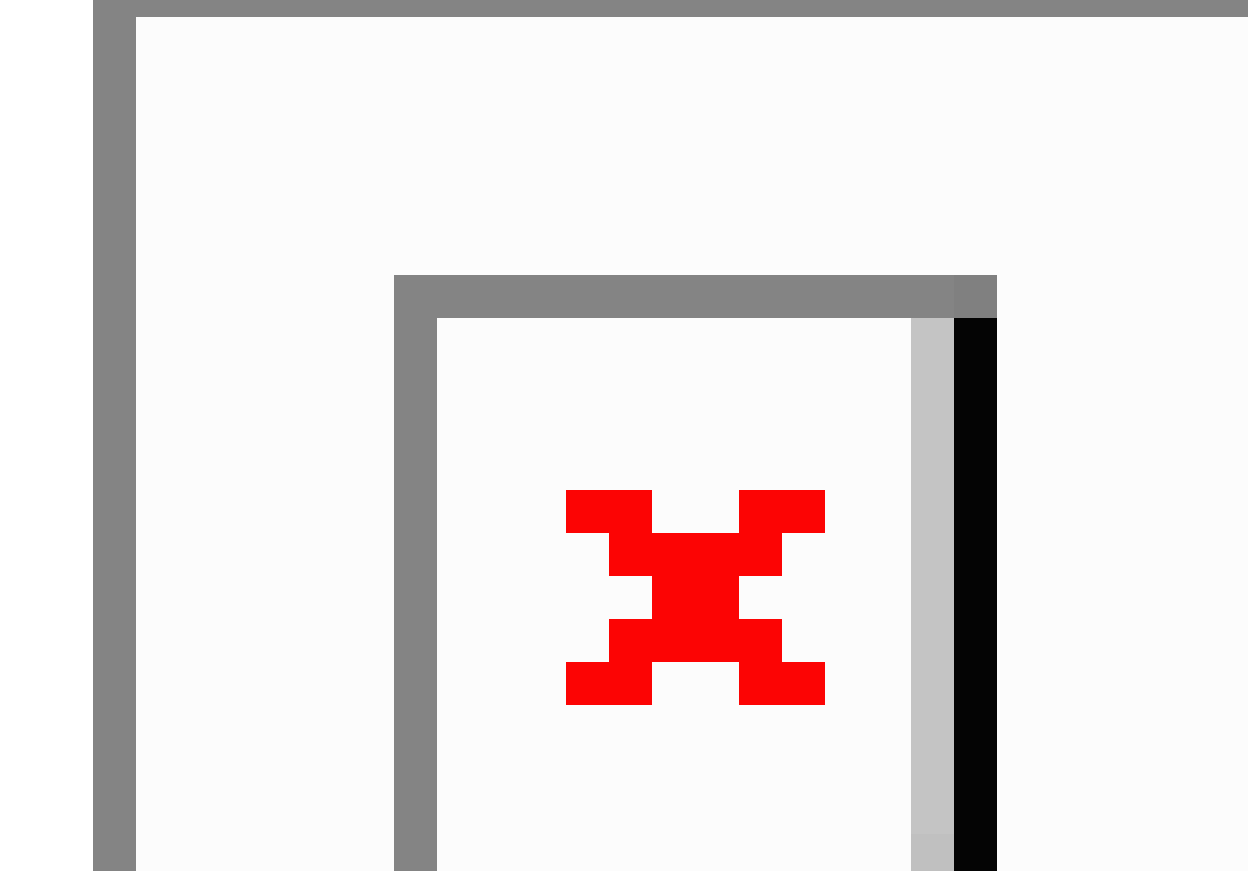
Figure 3. Satisfaction with the mindfulness introduction and exercises at